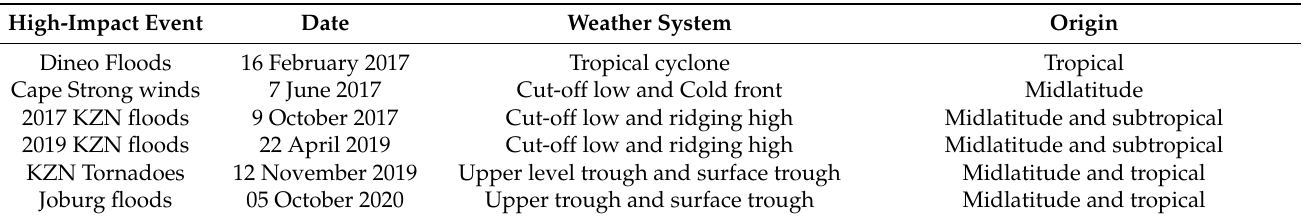
Figure 4. The ERA5 reanalysis sea level pressure in shaded colors and 500 hPa geopotential heights in white labeled contours for ( a ) 9 October 2017, ( b ) 22 April 2019 and ( c ) 12 November 2019 and the same variables for CCAM MN9km ( d ) 9 October 2017, ( e ) 22 April 2019 and ( f ) 12 November 2019. Table 2. Selected case studies of high-impact weather in South